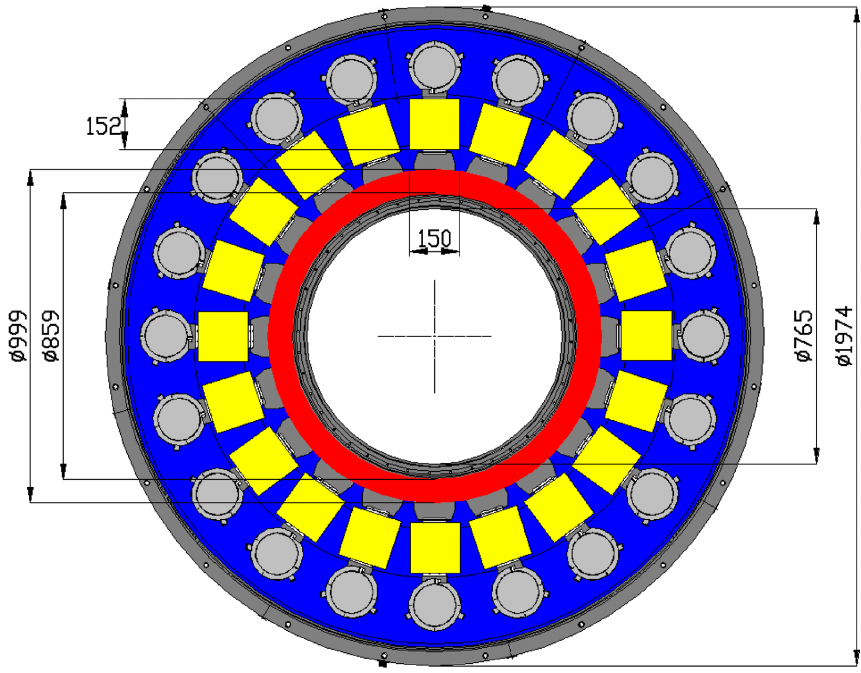
FIG. 1. Top view of the LTD cavity with 5th harmonics and total number of bricks s þ m þ f ¼ 20 . The dimensions here and in Fig. 2 are given in millimeters.